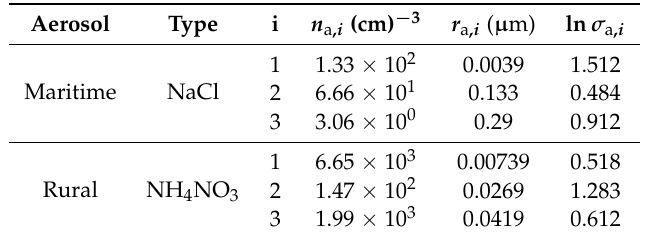
Table 1. Aerosol size distributions for maritime and rural conditions after Jaenicke [45]. Here, the type defines the chemical species, i depicts the mode, n a, i is the number concentration of aerosol of that mode per cubic centimeter, r a, i is the dry aerosol radius in microns and ln σ a, i is the logarithmic width of the distribution.